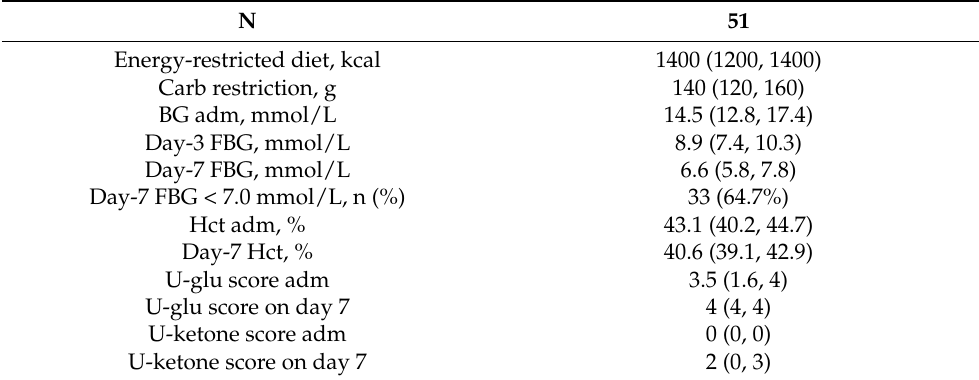
Table 2. Diet, carbs, glucose level, and urine test.